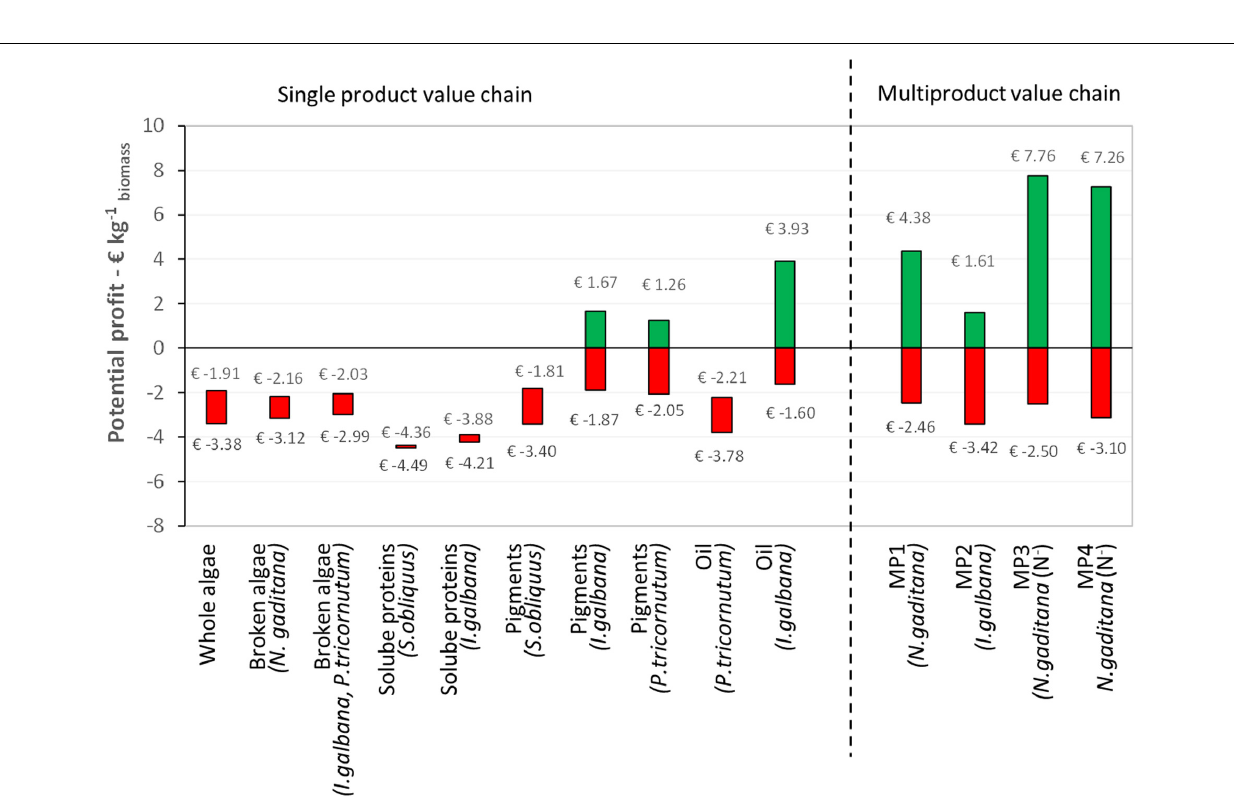
Frontiers in Bioengineering and Biotechnology |